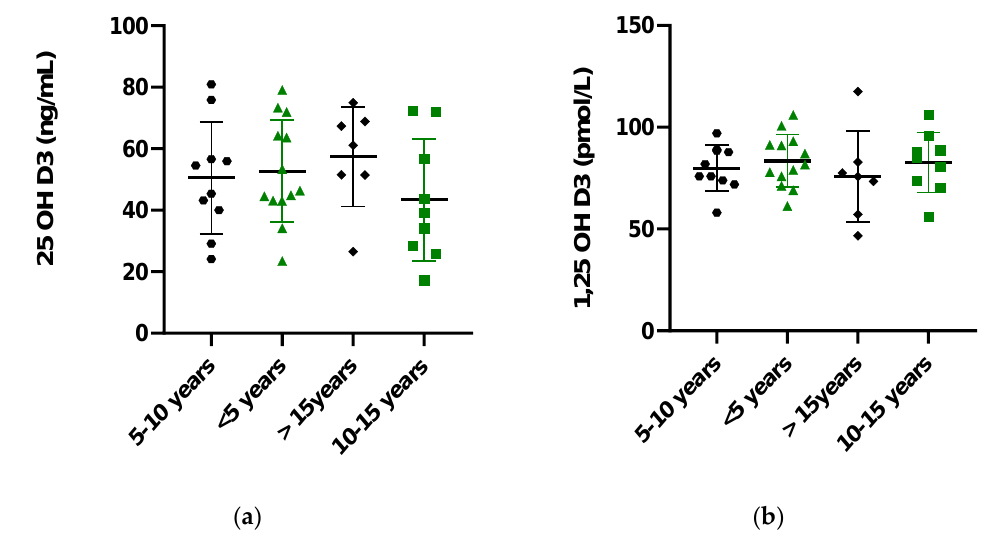
Figure 5. Serum concentration of 25-hydroxy Vitamin D (25(OH) Vitamin D) ( a ) and 1,25-hydroxy Vitamin D (1,25(OH)2 Vitamin D) ( b ) in IBD patients with respect to disease duration. Table 2. Laitinen’s pain scale results in enrolled IBD patients.